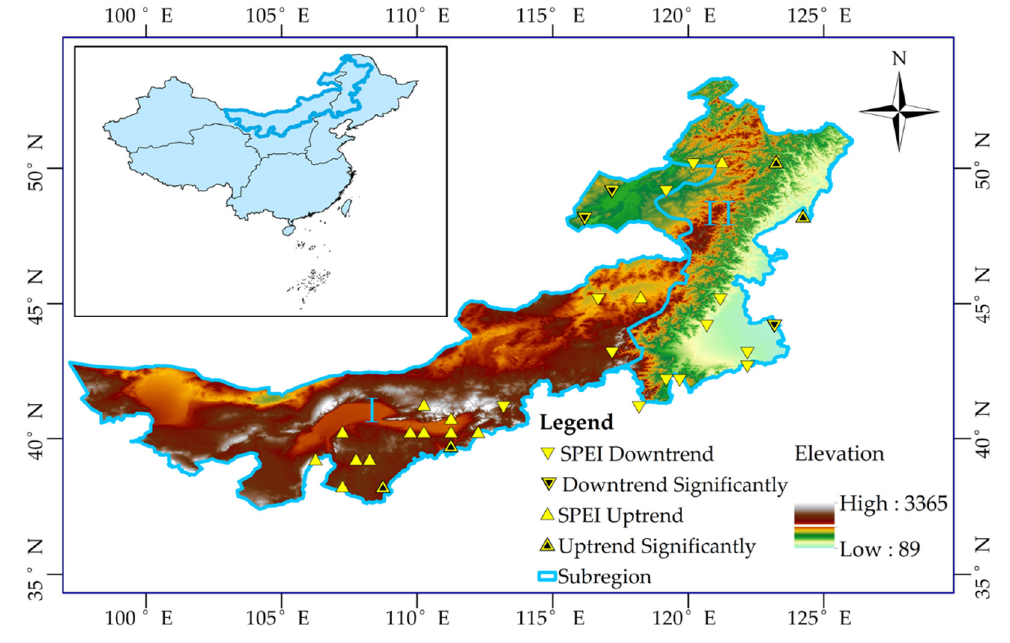
Figure 1. Study region.